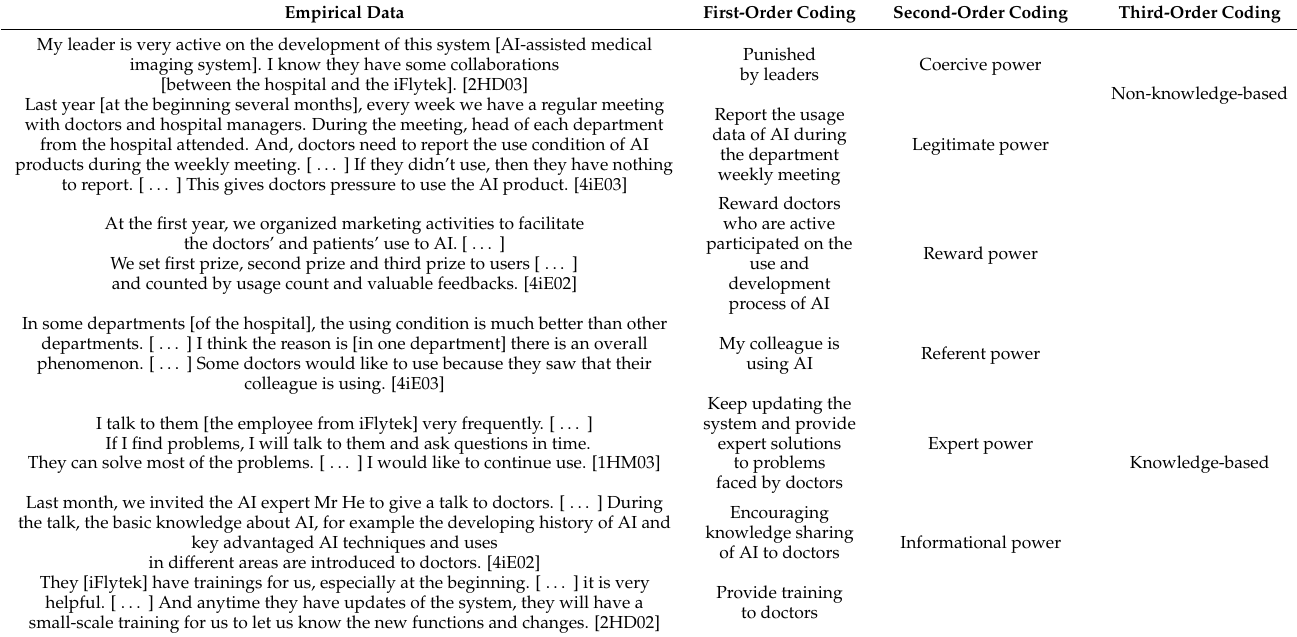
Table 5. Example of the interview data coding